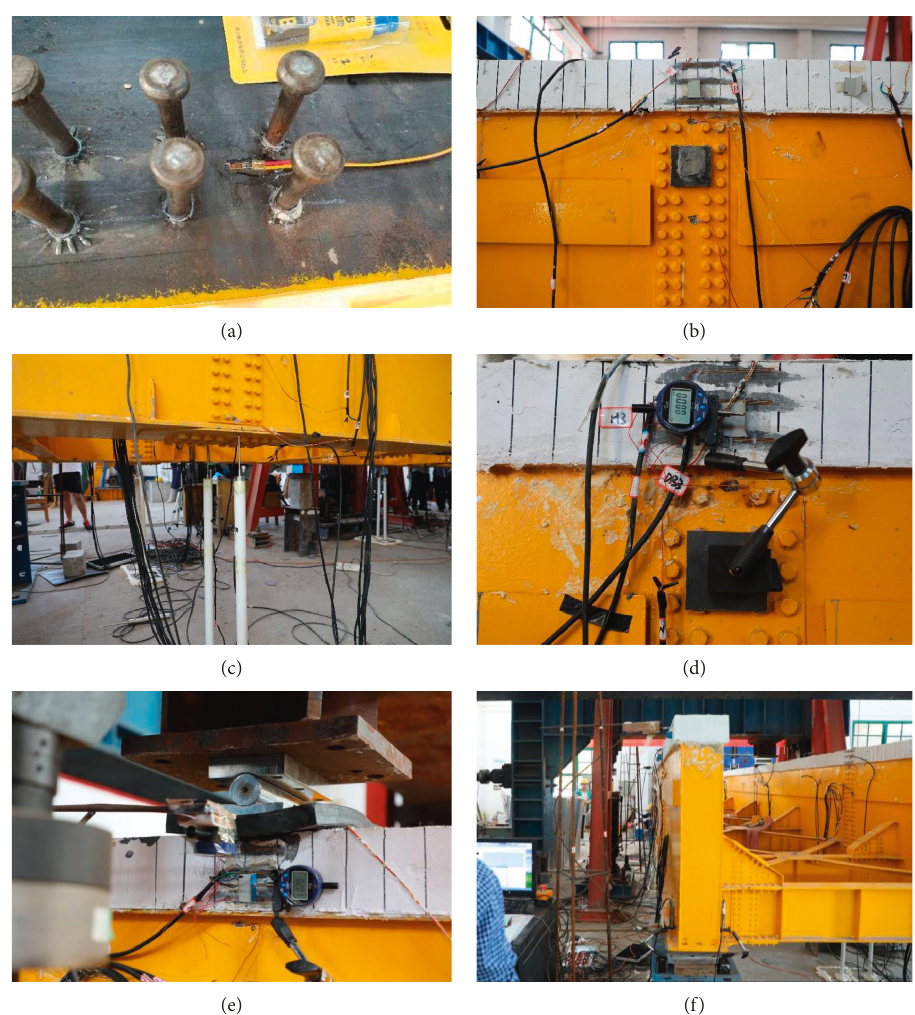
Figure 8: Static test scheme. (a) Strain gauge in the notch. (b) Strain gauge of the concrete slab. (c) Measuring points of displacement meters. (d) Measuring point of interface slip. (e) Roller support of load point of test beam. (f) Pin support at the end of the